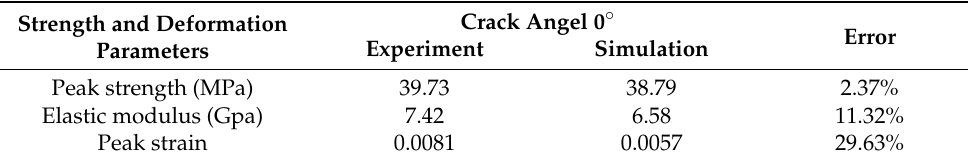
Figure 5. Calibration of the numerical model parameters. Table 3. Strength and deformation parameters of the sandstone samples in the experimental and numerical simulation experiments.